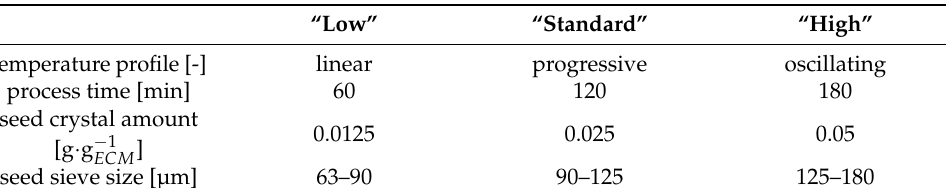
Table 1. Parameters that have been varied throughout the characterization experiments performed in this work.